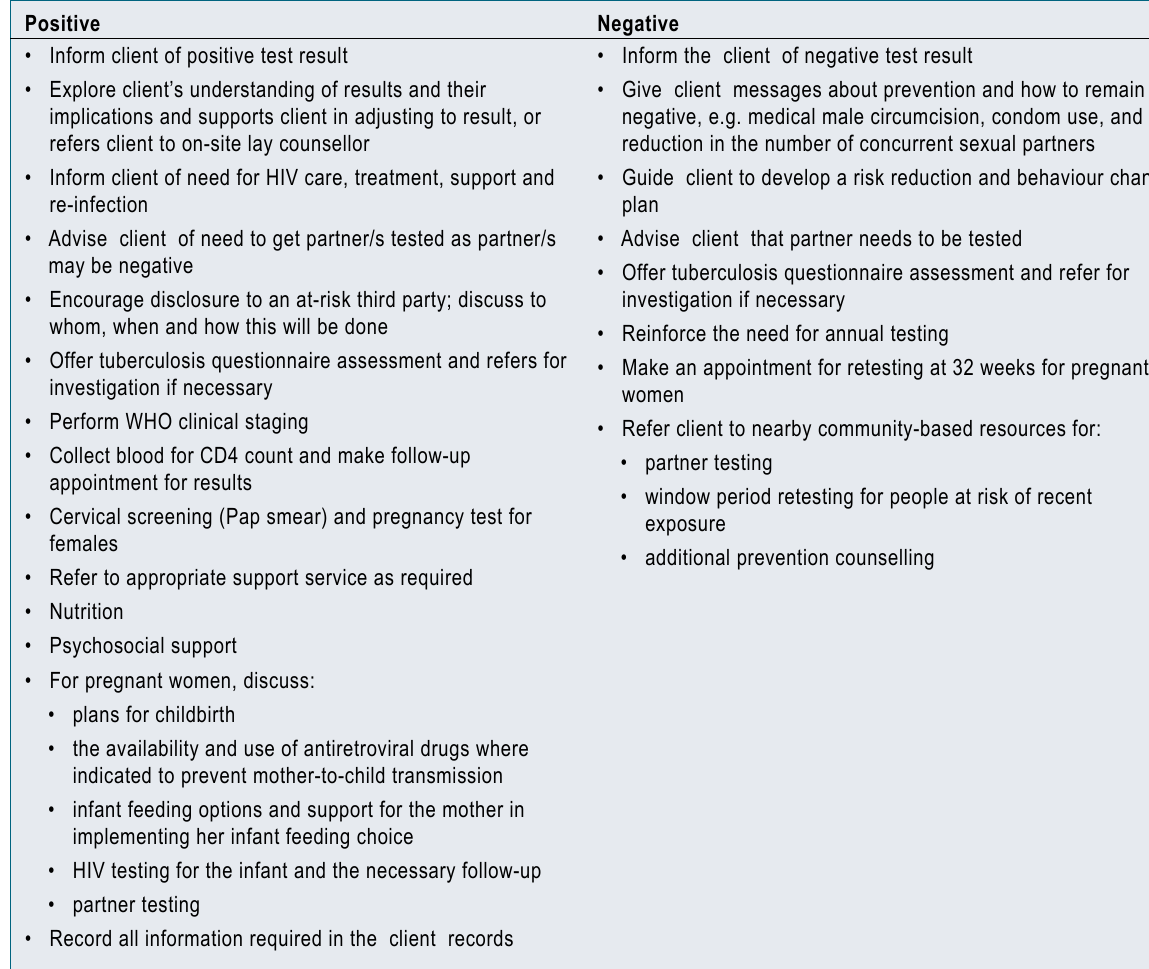
Fig. 1. The PICT protocol (source: HCT Policy Guidelines, 2010, NDoH 4 TABLE II. POST-TEST COUNSELLING